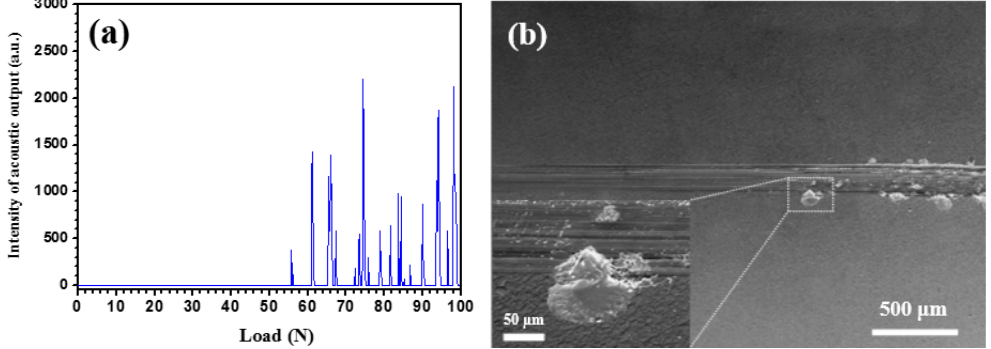
Figure 6. ( a ) Acoustic emission signal peaks versus normal load curve and ( b ) SEM image of the scratch track for the Ta 2 N coating.